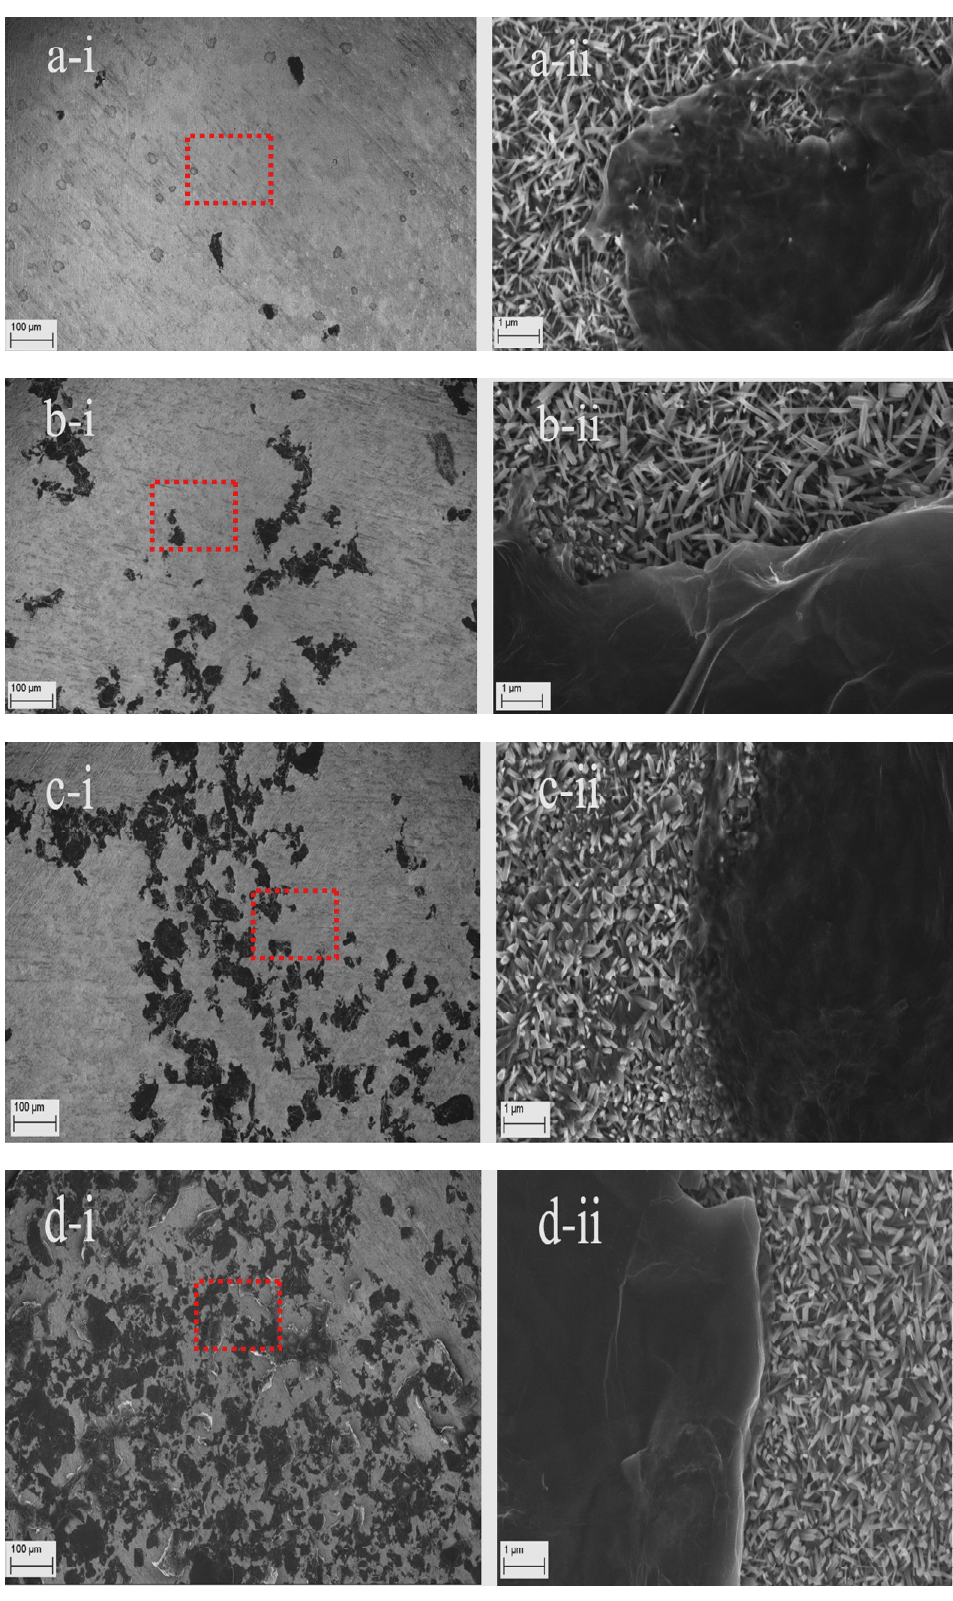
Figure 3. FESEM images of rGO deposited on TNWs using EPD with different deposition times: ( a ) 10 s; ( b ) 30 s; ( c ) 1 min; and ( d ) 5 min. Low-magnification images: left side (( a - i ) to ( d - i )) and high-magnification images: right side (( a - ii ) to ( d - ii )).